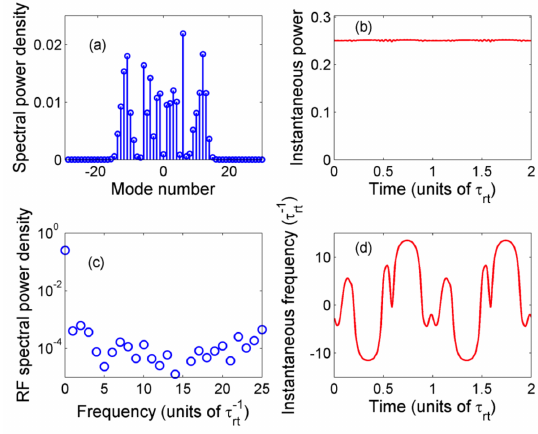
Figure 8: Maxwell-Bloch model of a mid-infrared QCL comb. a Op- tical spectrum. b Instantaneous intensity as a function of time. c RF spectrum of the intensity. d Instantaneous optical frequency. Results published in [64].